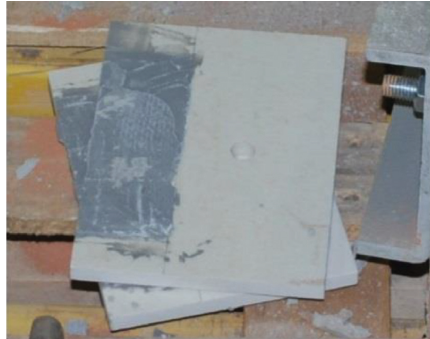
Figure 7: Shear failure of the adhesive in samples 1a-b.